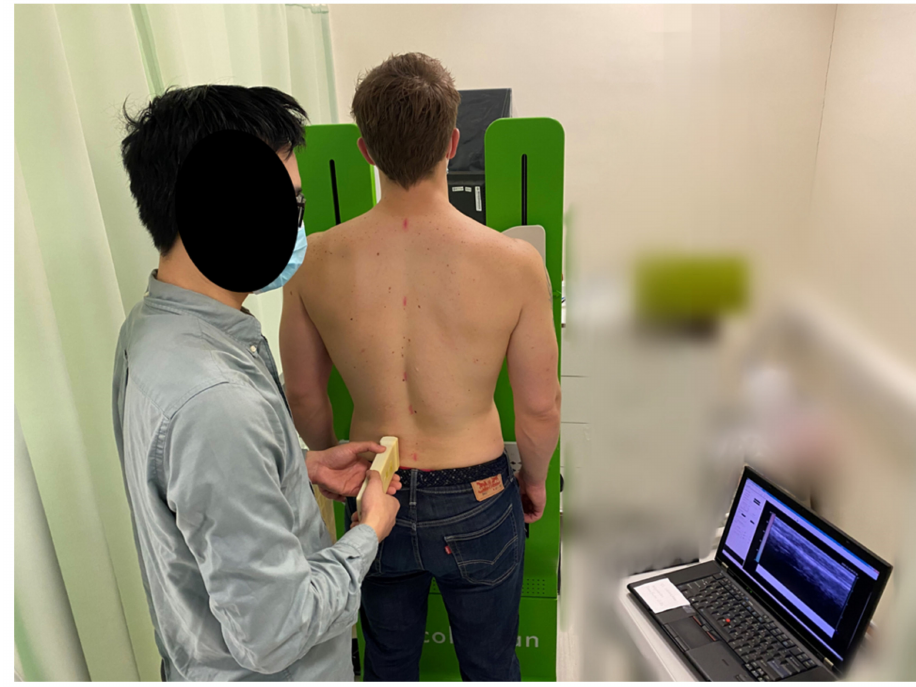
Figure 1. Illustration of the assessment in standing position with a supporting